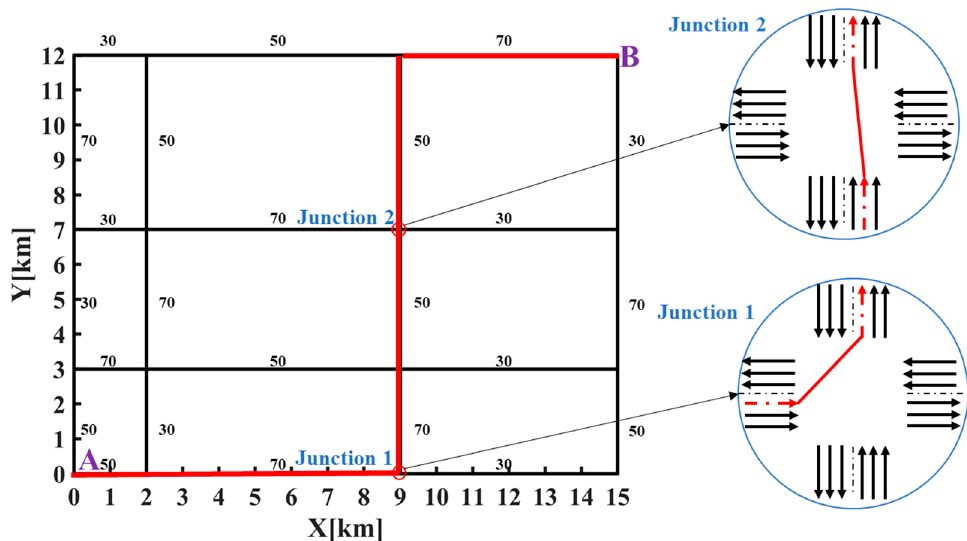
Figure 11. Abstraction of the simulated road network. The red lines show the planned route. A and B are the start and end of the route.